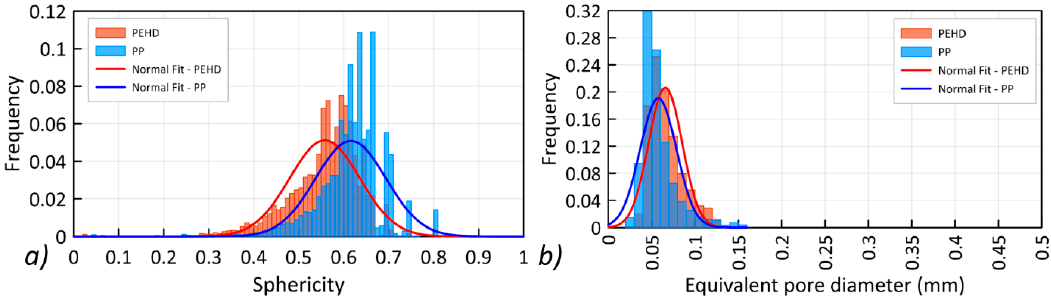
Figure 12. Characteristics of pores registered in the composite: ( a ) sphericity, ( b ) equivalent pore diameters.